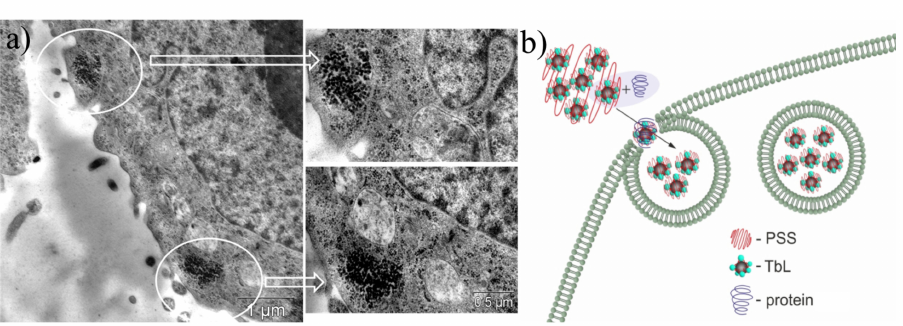
Figure 14. ( a ) TEM image of Hep-2 (human larynx carcinoma) cells incubated with PSS-[Tb 28a ] colloids. White circles designate the localization of the nanoparticles. ( b ) Schematic illustration of BSA (bovine serum albumin) assisted cell internalization of PSS-[Tb 28a ] colloids. Reproduced from Ref. [107] with permission from the